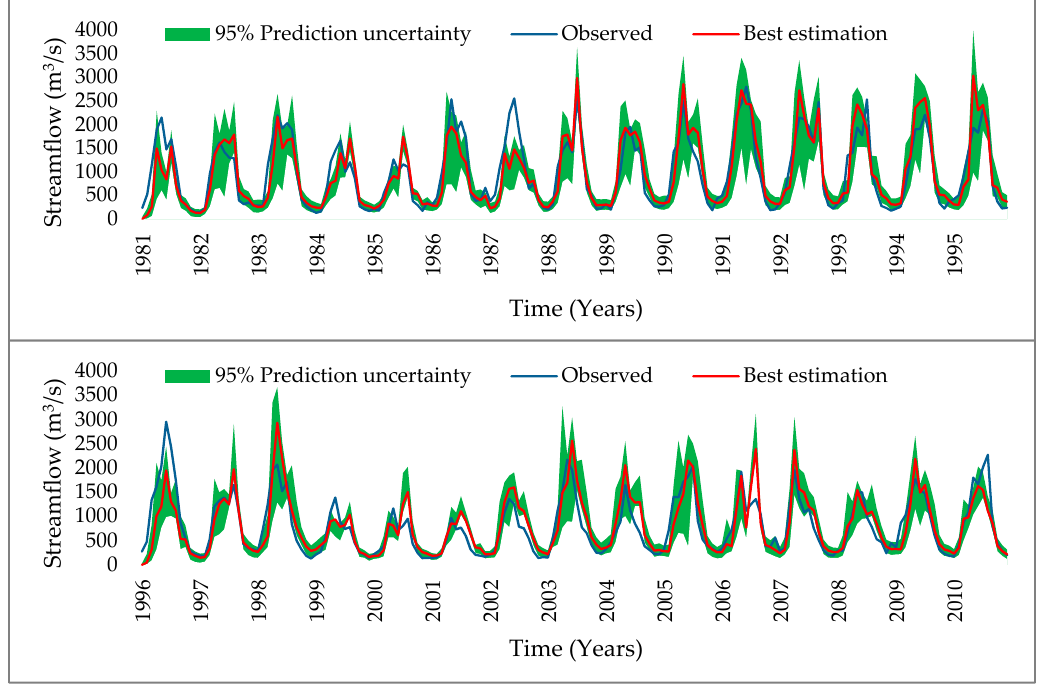
Figure 5. Comparison of simulated flow with observed flow considering elevation bands; calibration ( up ) and validation ( down ). Table 6. Explanation of sensitive parameters, along with their initial and adopted